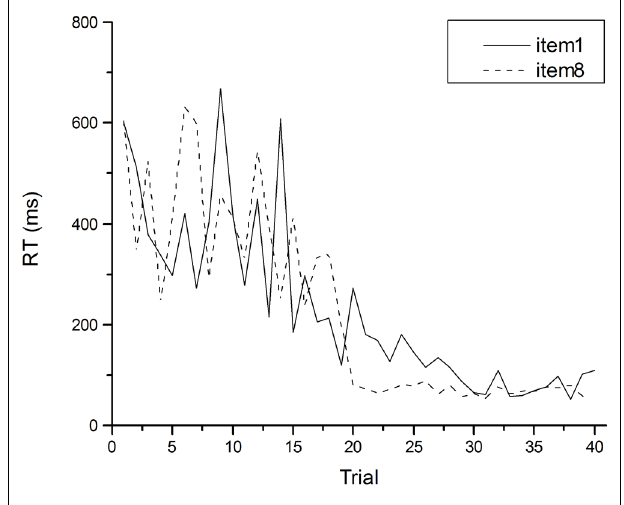
FIGURE 3 |An individual’s RT as a function of practice for specific items in the arithmetic task of Figure